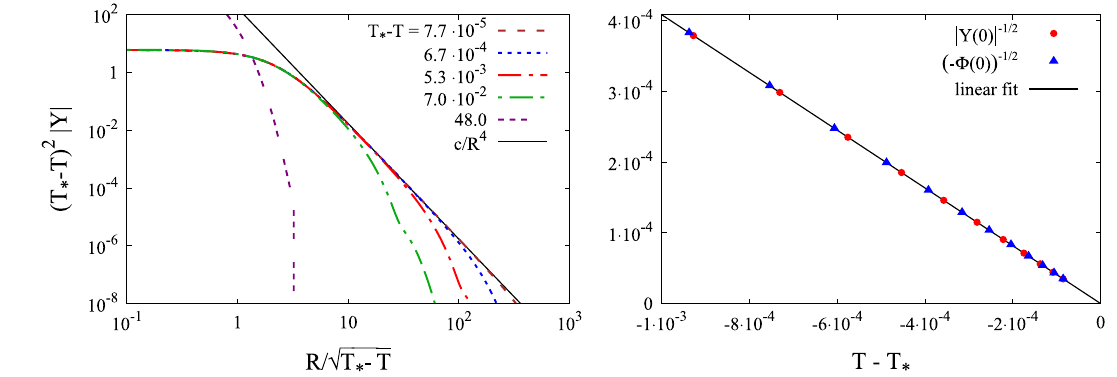
Fig. 7 Profile of the complex scalar field Y ( T , R ) for Ω in = 0 . 6 in the self-similar coordinates (left plot) and behaviour of the scalar fields Y ( T , R ) and Φ( T , R ) for T → T ∗ (right plot). Here c ≈ 170, T ∗ ≈ 48